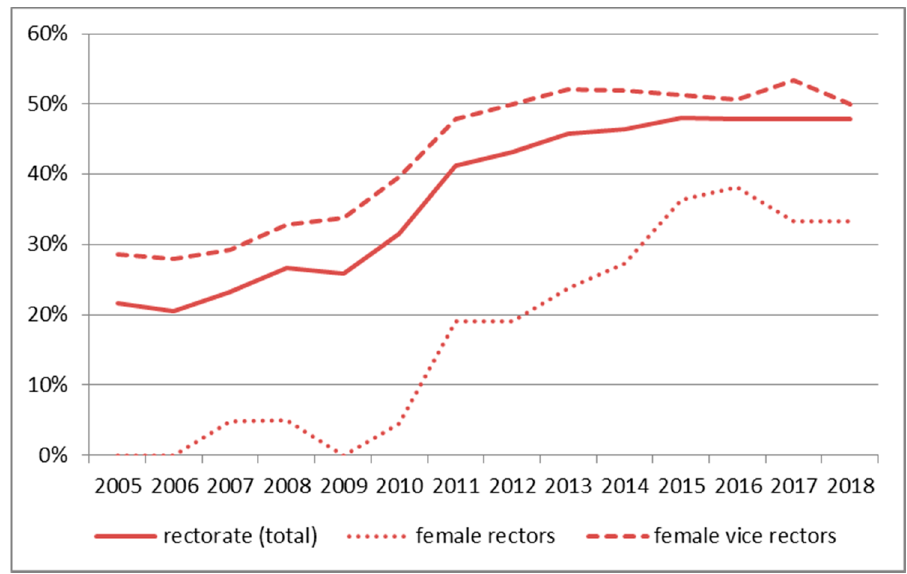
Figure 1. Female rectors and vice rectors 2005–2017. Source: Federal Ministry for Eduation, Science and Research (unidata).